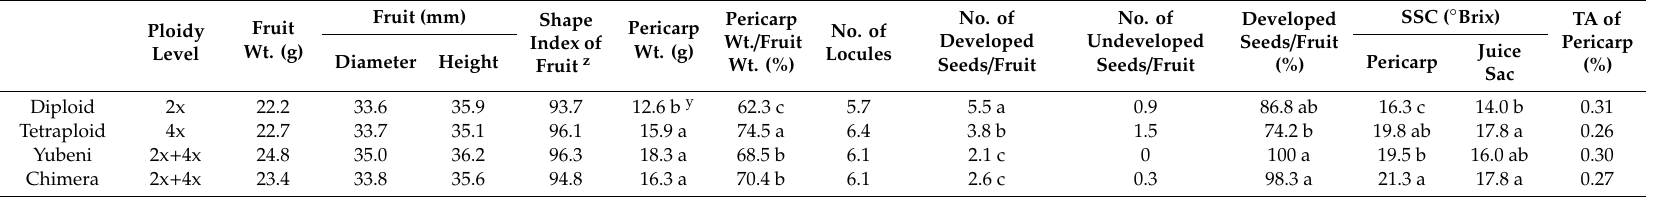
Table 6. Seed content and ploidy level of the seedlings obtained from the reciprocal crosses between the diploid and the chimera of the Meiwa kumquat. Cross Combination No. of Seeds No. of Ploidy Level Av. No. of Developed No. of Developed Developed Seedlings Seed Seeds (%) y Fruits Pollen Parent Developed Undeveloped 2x 3x 4x Seed Weight Seeds / Fruit Examined Parent Diploid